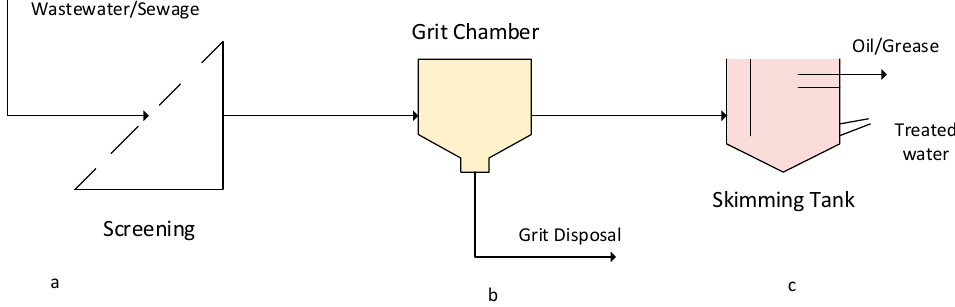
Figure 3. Primary treatment process ( a ) screening process ( b ) grit chamber and ( c ) wastewater skimming tank.